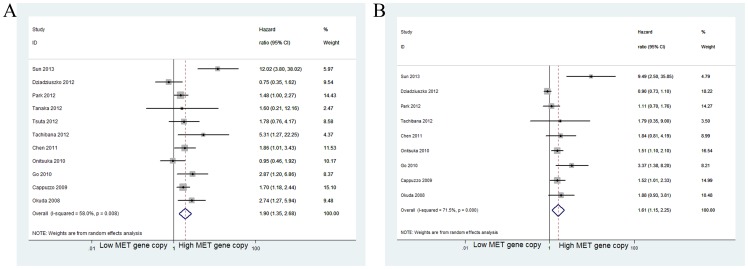
Meta-analysis of effects of the MET gene copy number on overall survival of patients with non-small cell lung cancer (NSCLC).Forest plot showing (A) the combined relative HR for OS by univariate analysis; (B) the combined relative HR for OS by multivariate analysis.